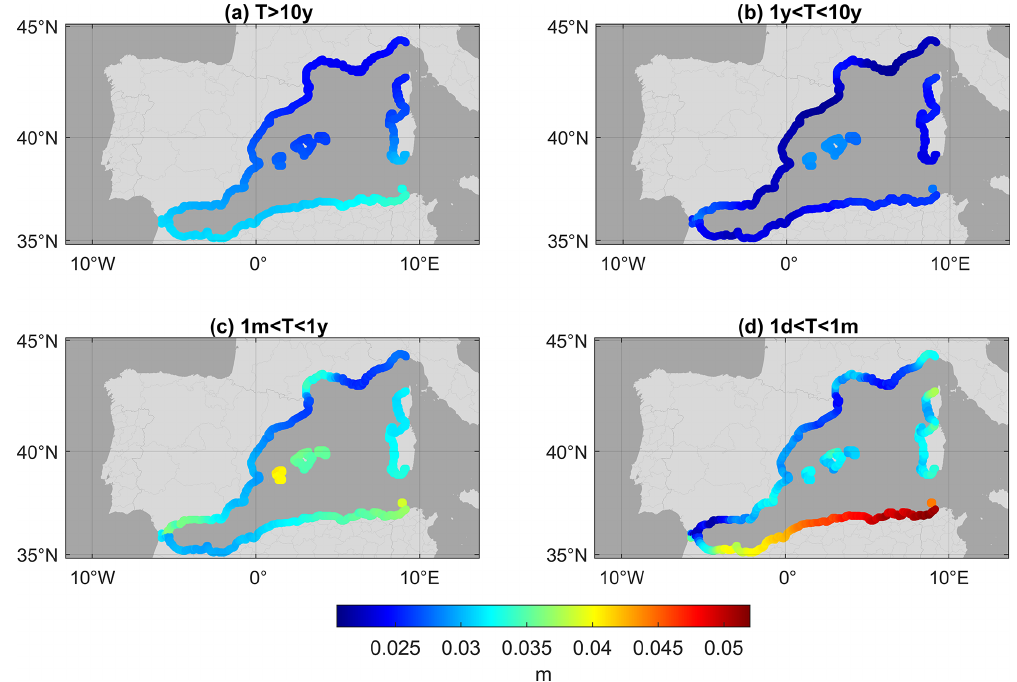
Figure B1. Temporal average of the analysis error (in meters) (a) for the band T > 10 y (b) for the band 1 y<T < 10 y , (c) for the band 1 m<T < 1 y , and (d) for the band 1 d<T < 1 m